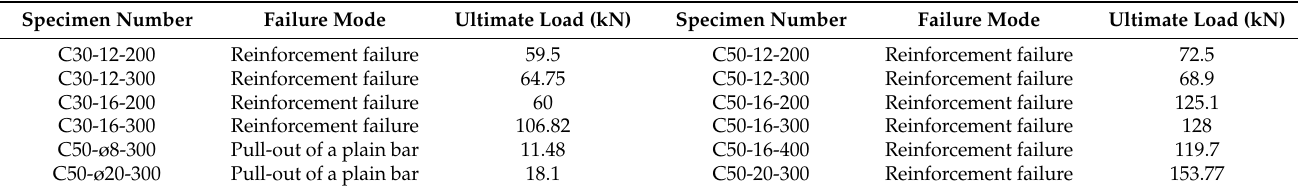
Table 3. Failure modes of reinforced concrete pull-out specimens.